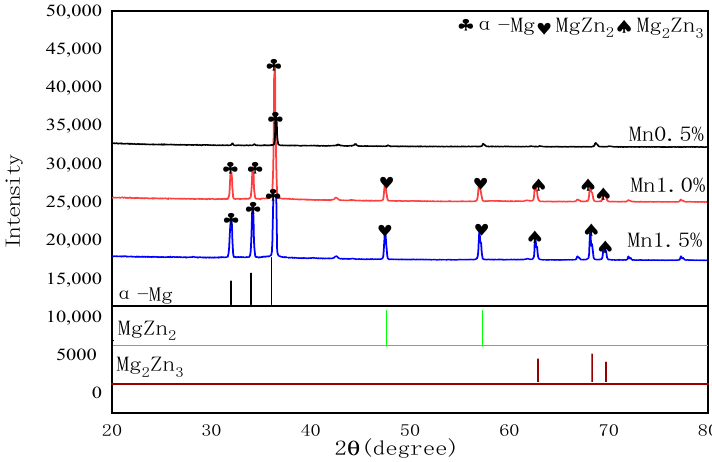
Figure 11. XRD phase composition analysis of Mg-Mn-Zn alloy.